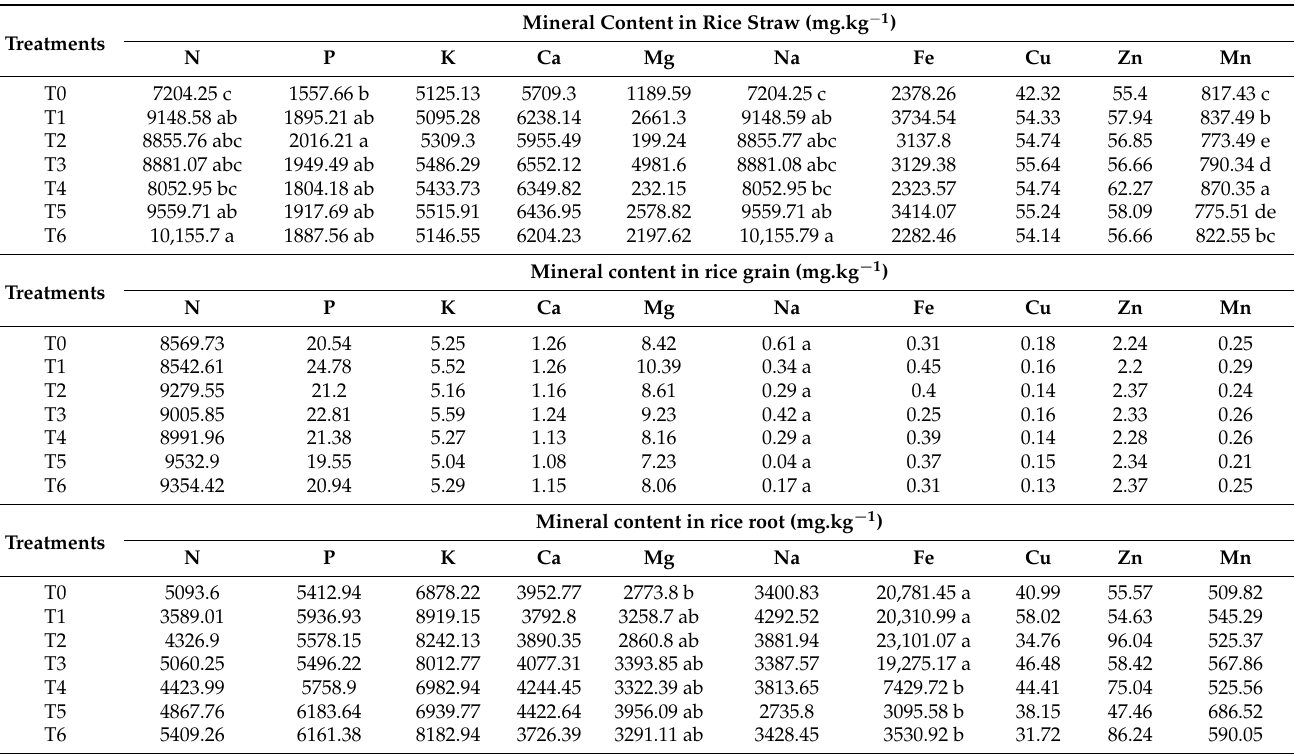
Table 5. Effects of fertilization treatments on nutrient accumulation in the rice plants; mean of 4